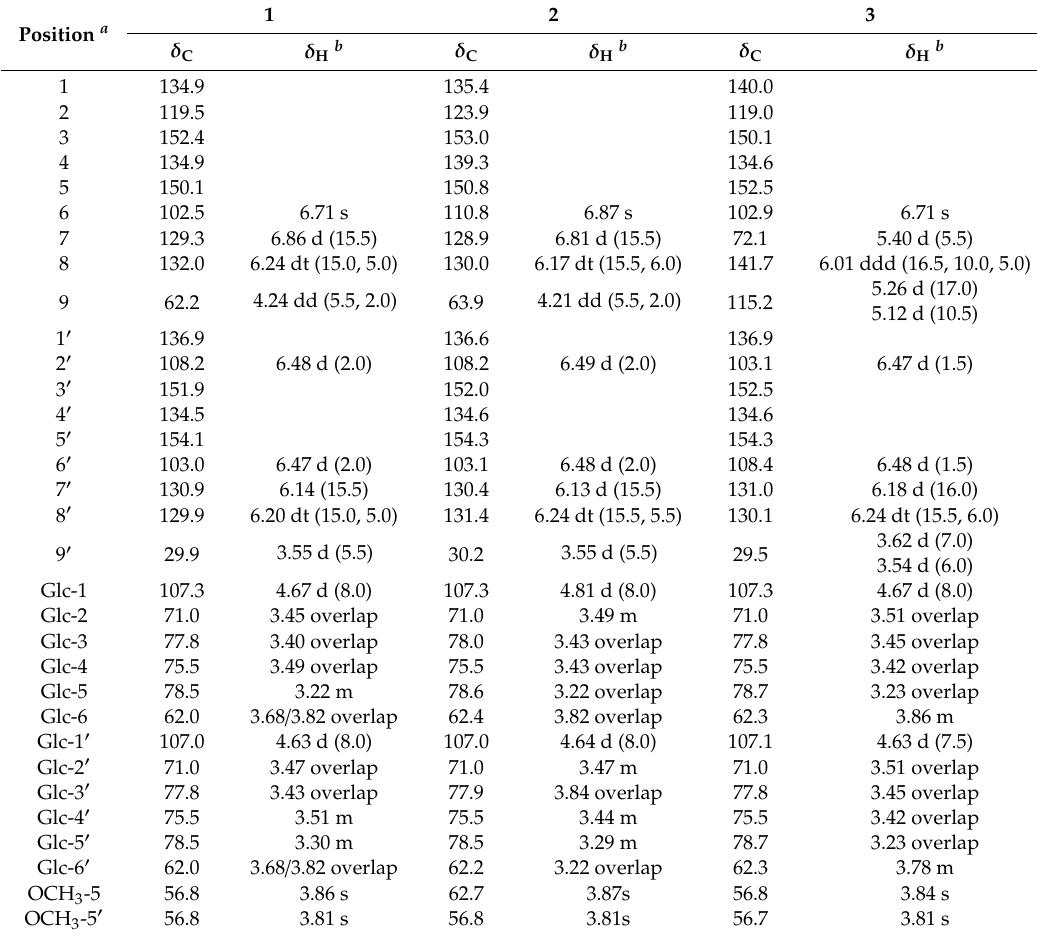
Table 1. 1 H and 13 C NMR spectroscopic data of compounds 1 – 3 ( δ in ppm, CD 3 OD, 500 and 125